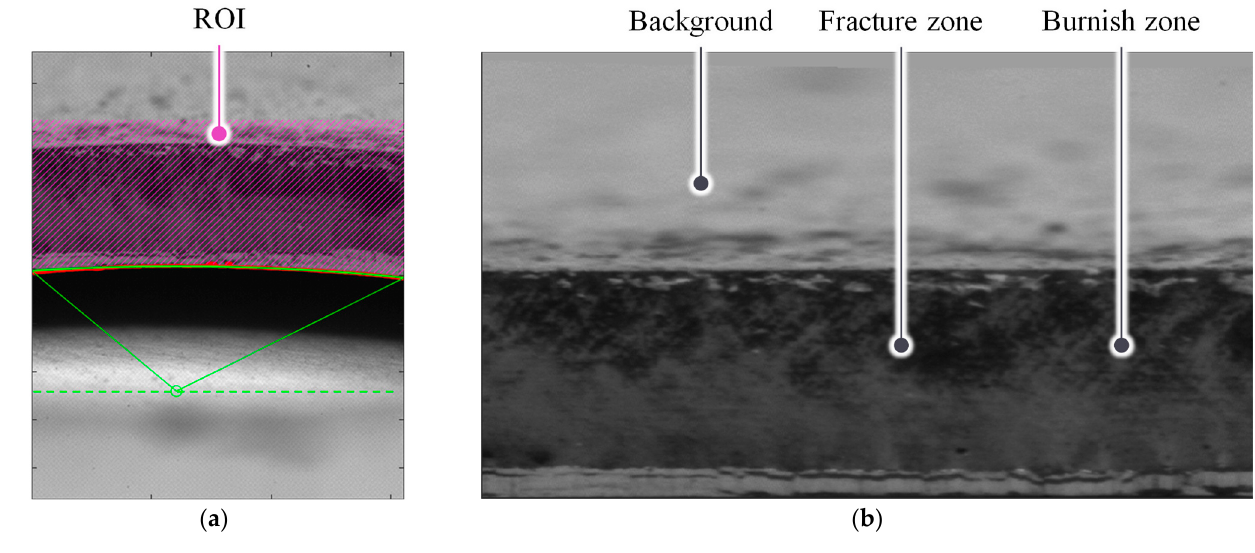
Figure 6. Image coordinate conversion from ( a ) cylindrical raw image to ( b ) Cartesian image.